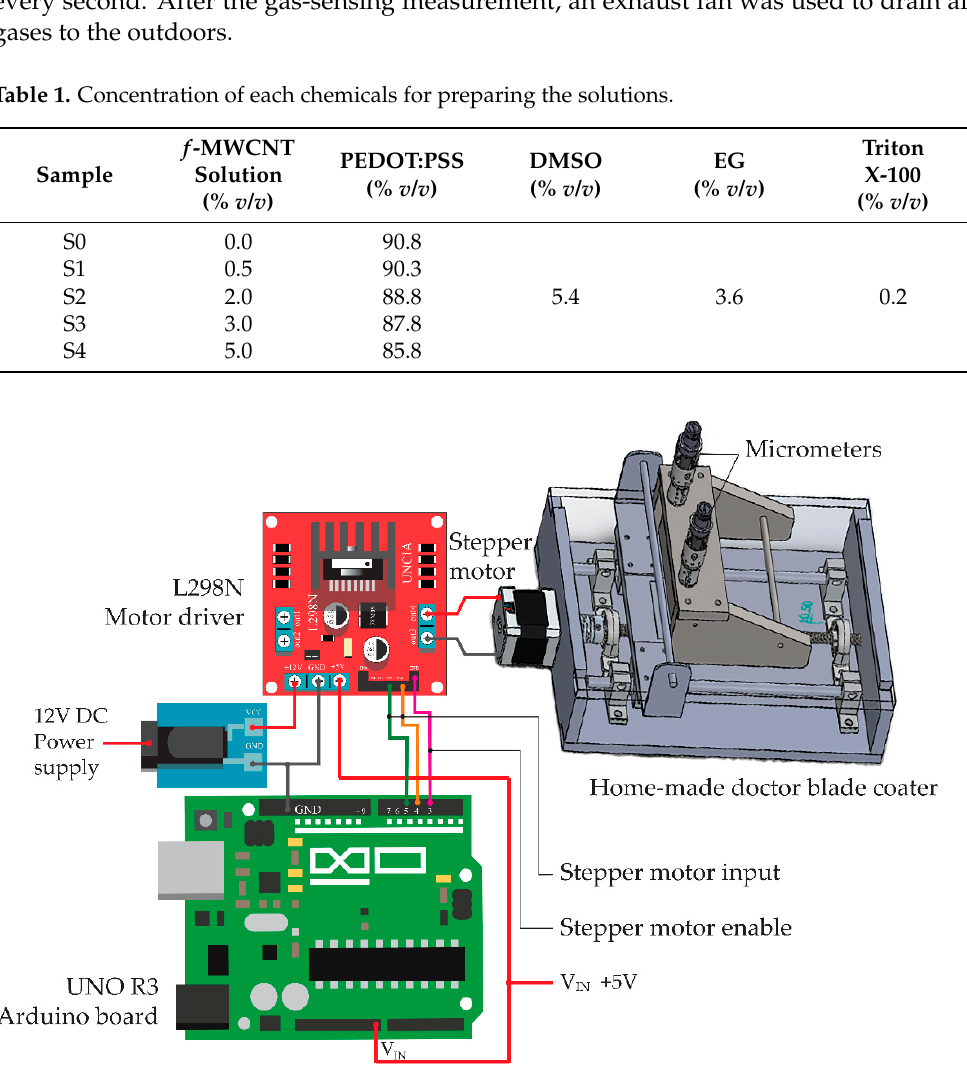
Figure 2. Photograph of gas-measurement system in this study. 3. Results and Discussion After the CVD process, the MWCNTs were grown on a full area of 304 SS foil. Figure 3 shows a photograph of a 1.6 × 3.0 cm 2 304 SS foil before (Figure 3a) and after (Figure 3b) CVD process. Surface morphologies of MWCNTs grown on 304 SS foil were characterized by scanning electron microscope (SEM, Quanta 450 FEI) with a working voltage and cur- rent of 30 kV and 10 μ A. To observe the density of MWCNTs more easily, a Scotch ® tape was conducted to remove the MWCNTs from some area of the foil as shown in Figure 4a. The MWCNTs on the 304 SS foils were ultrasonically sonicated in the DMSO solvent and dropped onto a copper grid. It was then inserted into a sample holder of a high-resolution transmission electron microscope (HRTEM, Hitachi HT 7700). The HRTEM was con- ducted using an accelerating voltage of 200 kV with a current of 60 μ A to examine the size of MWCNT diameter. It can be confirmed that the samples are multiwalled carbon nano- tubes with a diameter size of ~35 nm, as shown in Figure 4b. The diameter measurements were calculated using an ImageJ software program in five different areas of the sample. It is seen that the average size of the diameter for the MWCNTs was found to be 35 ± 5 nm.